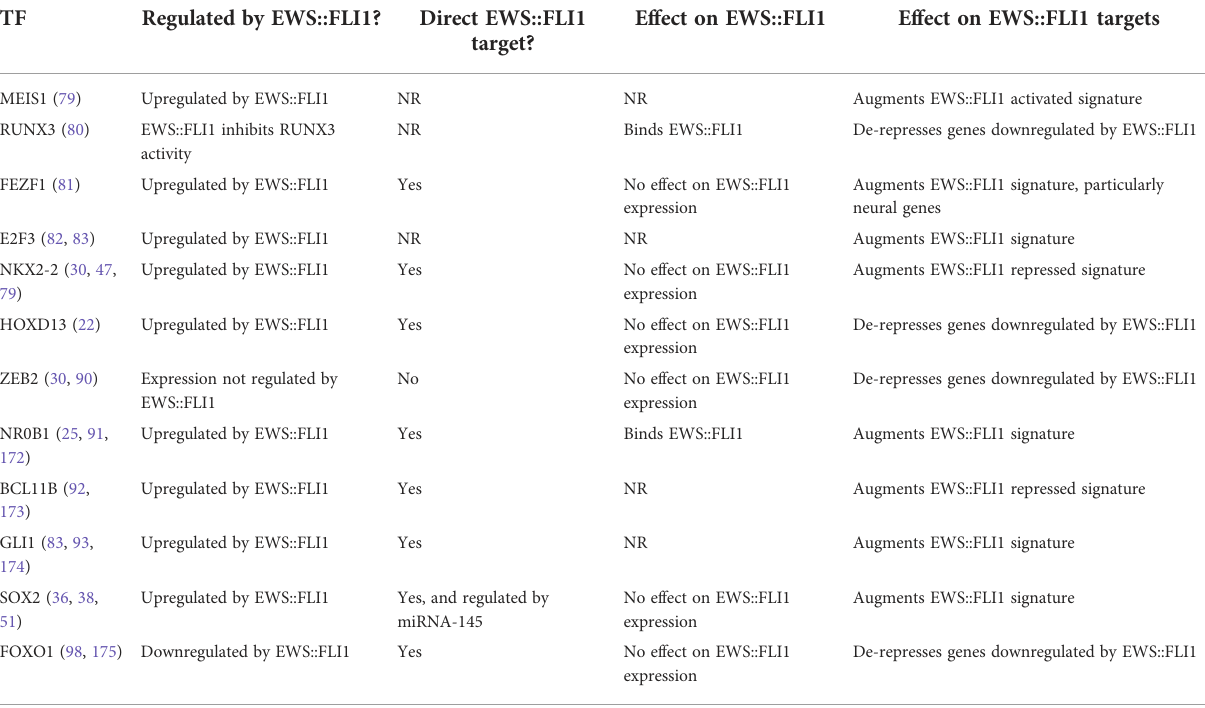
TABLE 1 Description of a select subset of transcription factors that are either regulated by EWS::FLI1 or play an important role in altering expression of EWS::FLI1